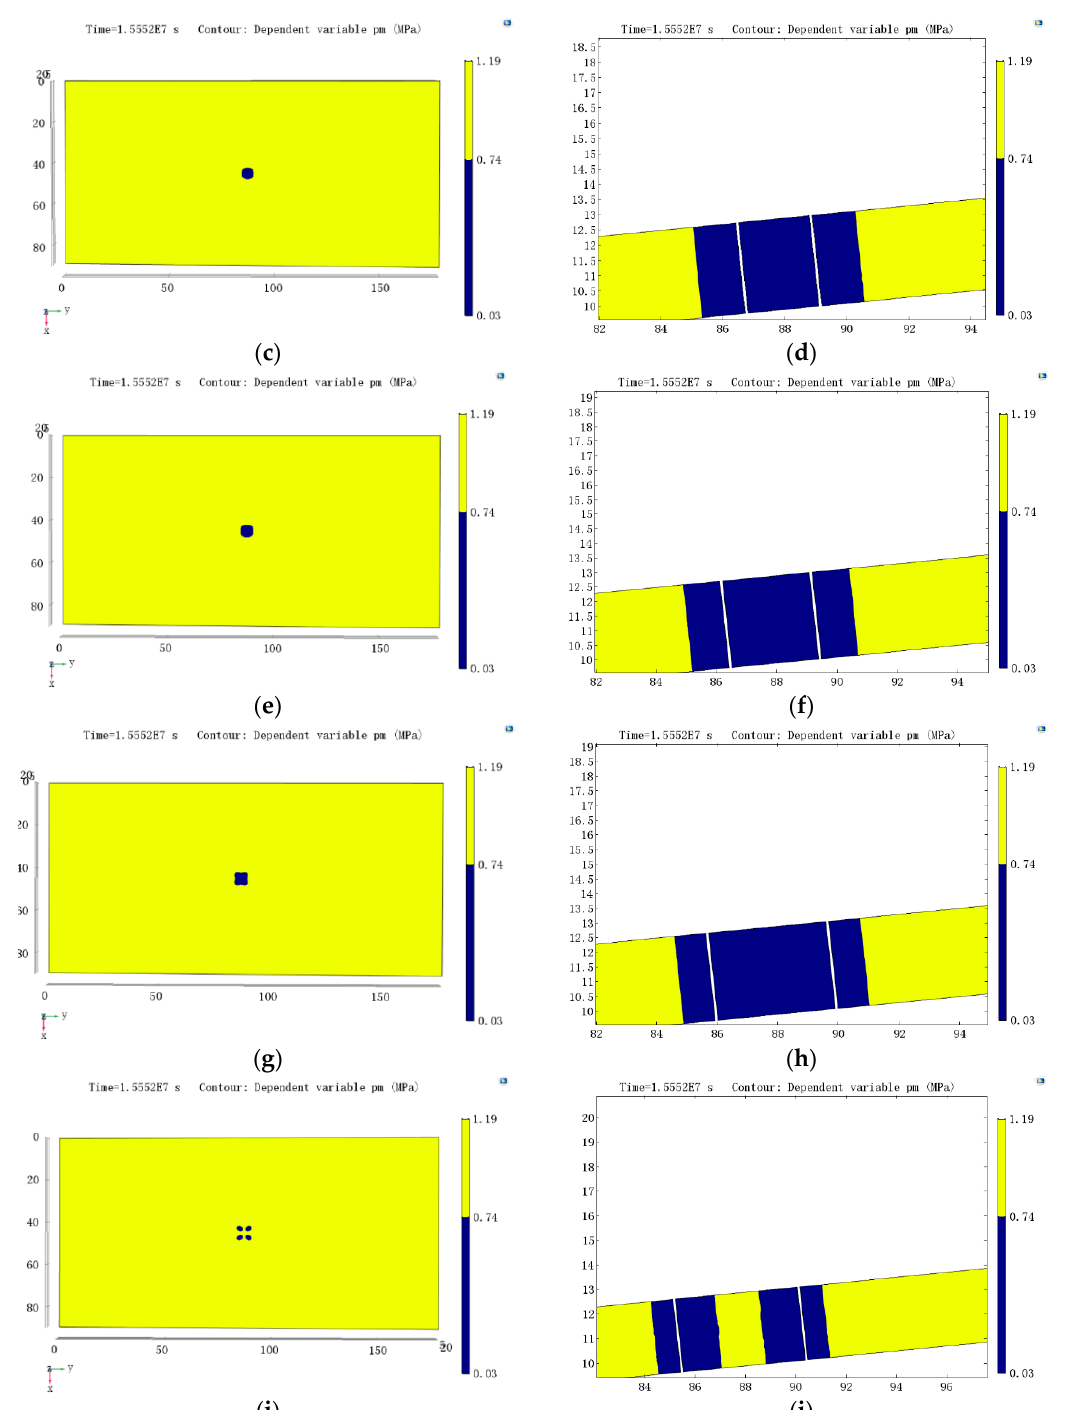
Figure 7. Outburst elimination areas formed by gas drainage from four boreholes at different spacings. Outburst elimination area formed by gas drainage from four boreholes at a spacing of 2.1 m: ( a ) inclined plane, ( b ) tangent plane. Outburst elimination area formed by gas drainage from four boreholes at a spacing of 2.4 m: ( c ) inclined plane, ( d ) tangent plane. Outburst elimination area formed by gas drainage from four boreholes at a spacing of 3 m: ( e ) inclined plane, ( f ) tangent plane. Outburst elimination area formed by gas drainage from four boreholes at a spacing of 4 m: ( g ) inclined plane, ( h ) tangent plane. Outburst elimination area formed by gas drainage from four boreholes at a spacing of 5 m: ( i ) inclined plane, ( j ) tangent plane.